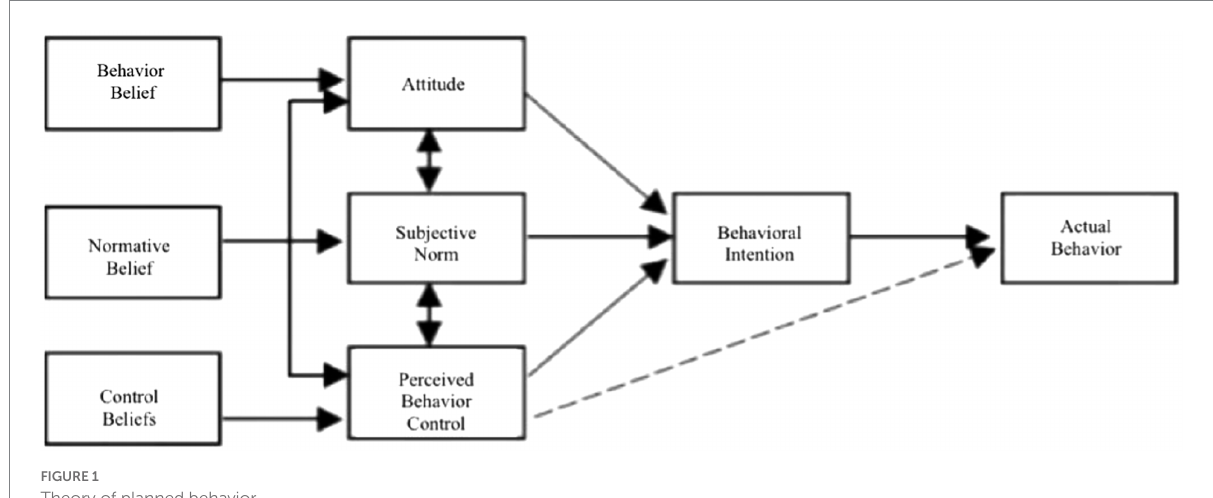
FIGURE 1 Theory of planned